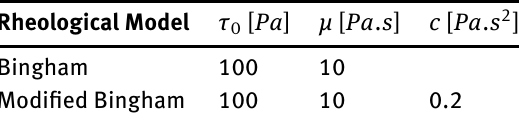
Table 1: The rheological values used for comparison are representa- tive for fresh concrete [31,